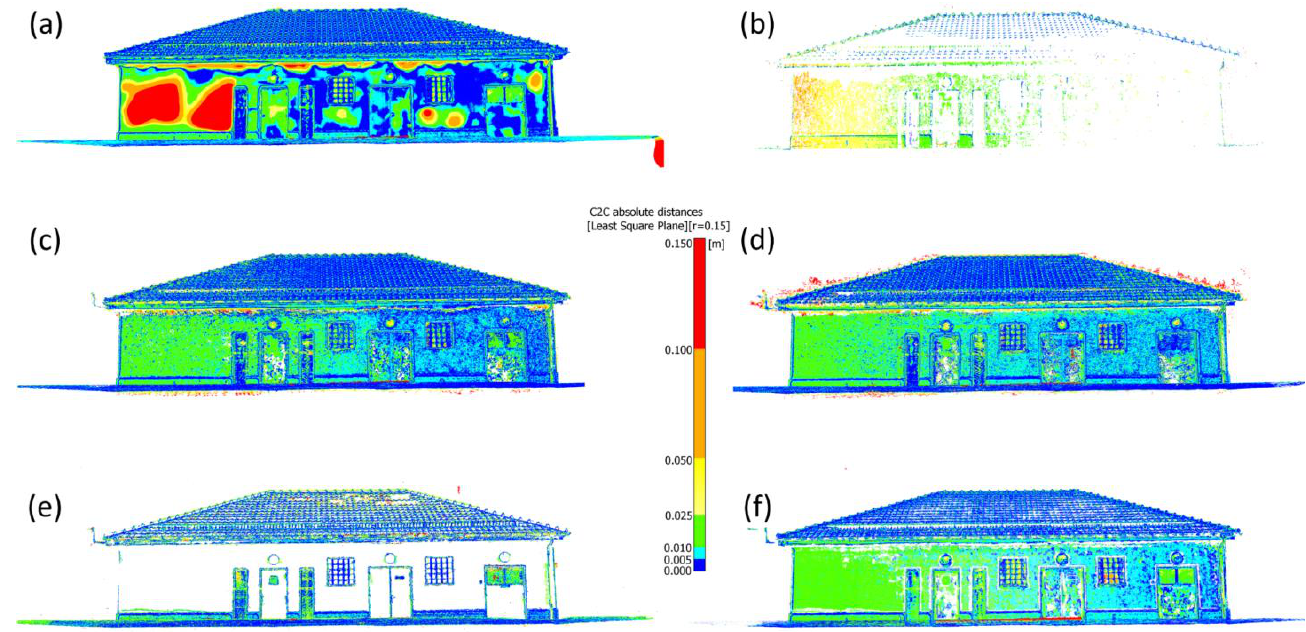
Figure A4. Comparison of TLS and image-based point clouds of elevation 2: ( a ) ContextCapture; ( b ) GRAPHOS; ( c ) Metashape; ( d ) PhotoScan; ( e ) Pix4DMapper; ( f ) RealityCapture.